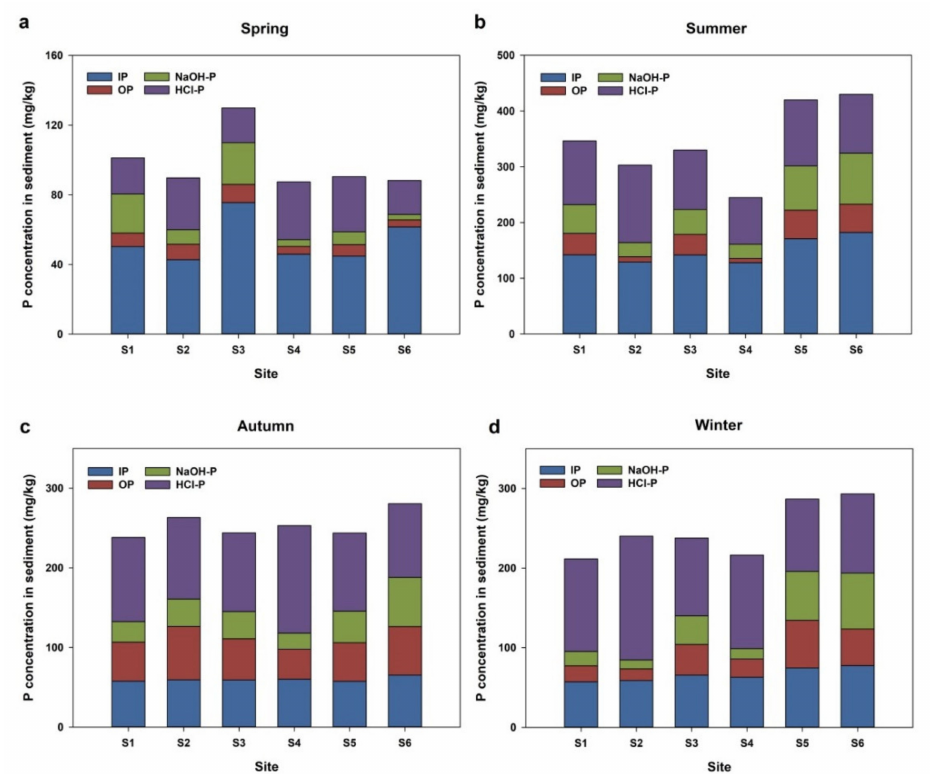
Figure 3. Spatial distribution of different forms of phosphorus (mg/kg) in spring ( a ), summer ( b ), autumn ( c ), and winter ( d ) in surface sediments of the QCS Reservoir,